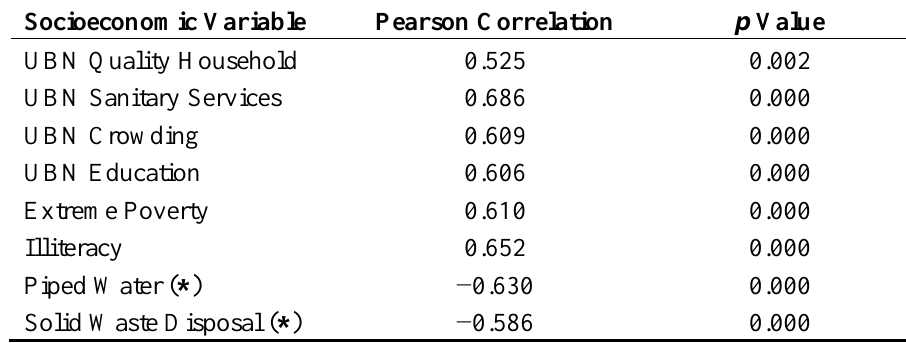
Table 2. Pearson correlation coefficients (and p values) between log-transformed rates and socioeconomic variables at the municipality level ( n = 32